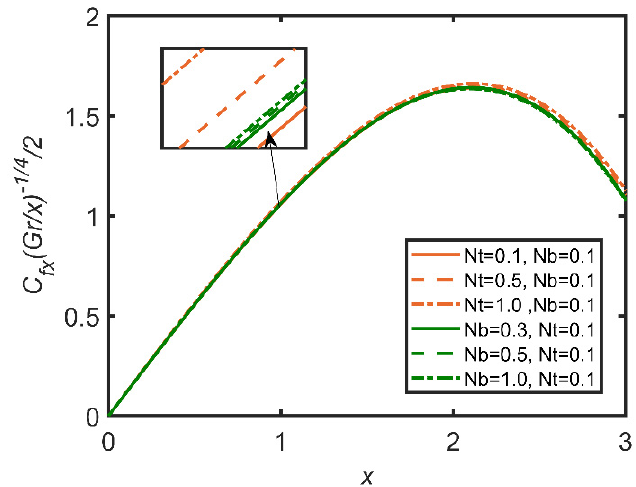
Figure 3. Comparison for skin friction against x.